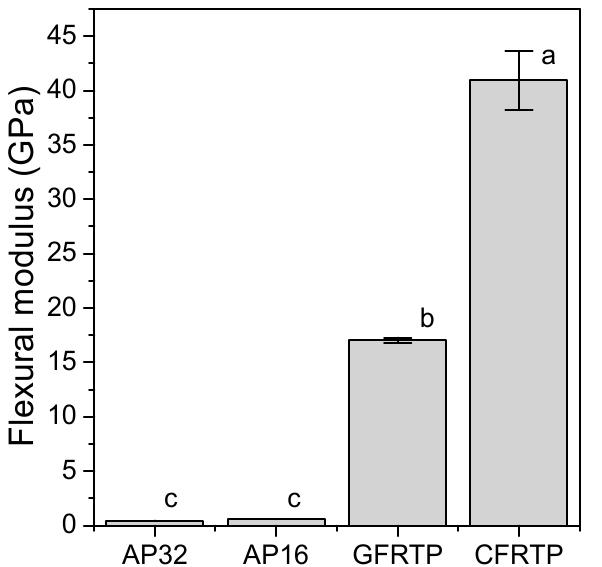
Figure 2. Flexural moduli of AP32, AP16, GFRTP, and CFRTP. Bars labeled with the same letter show no significant difference ( p > 0.05).